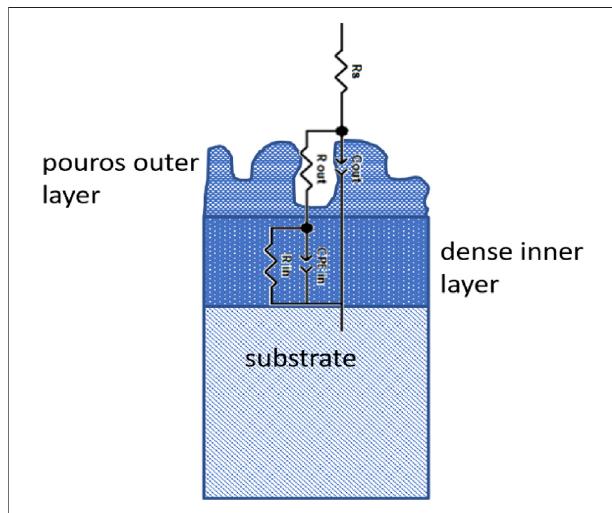
FIGURE 12 | Scheme of equivalent circuit for PEO-treated surfaces